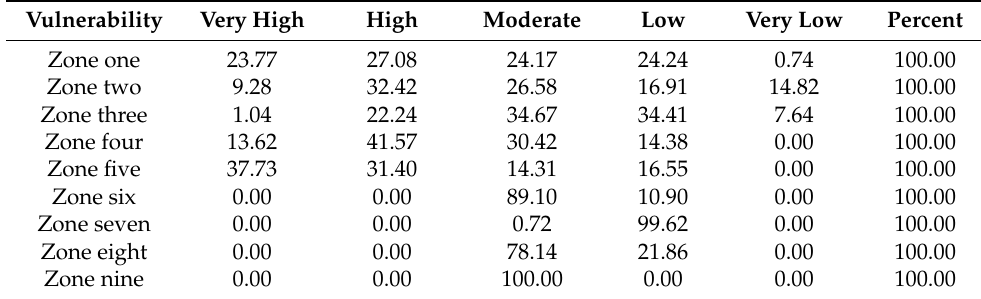
Table 5. Assessment of Population Vulnerability (PV) in Tabriz according SOM Method.